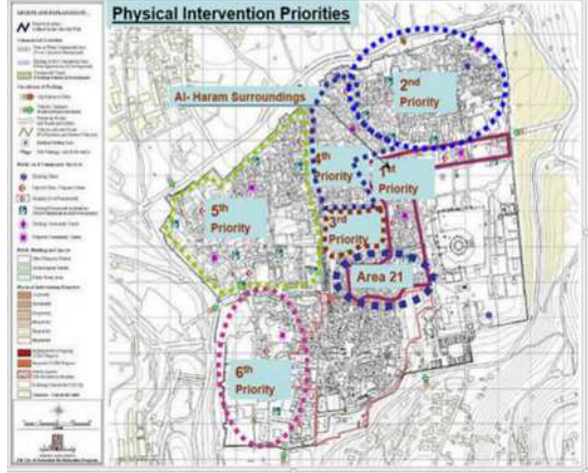
Figure 9. Old City of Jerusalem, thematic map showing the priority areas (Husseini and Bali,